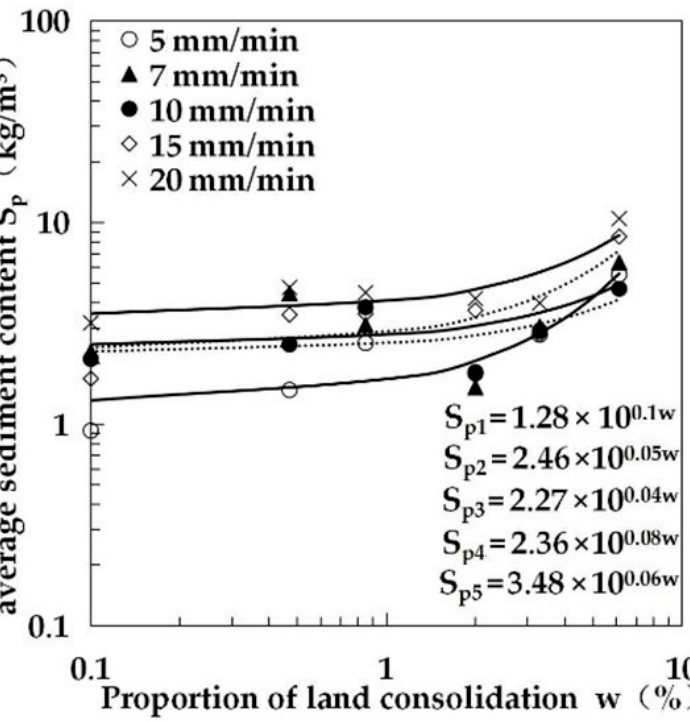
Figure 26. Changes in average sediment content at the outlet section with land consolidation proportion under different rain intensities.